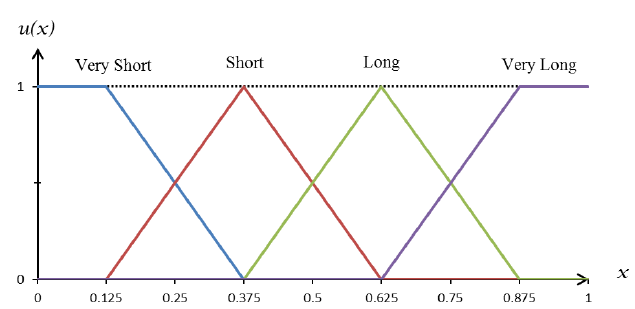
Figure 3. Membership function of the linguistic variables for length style.